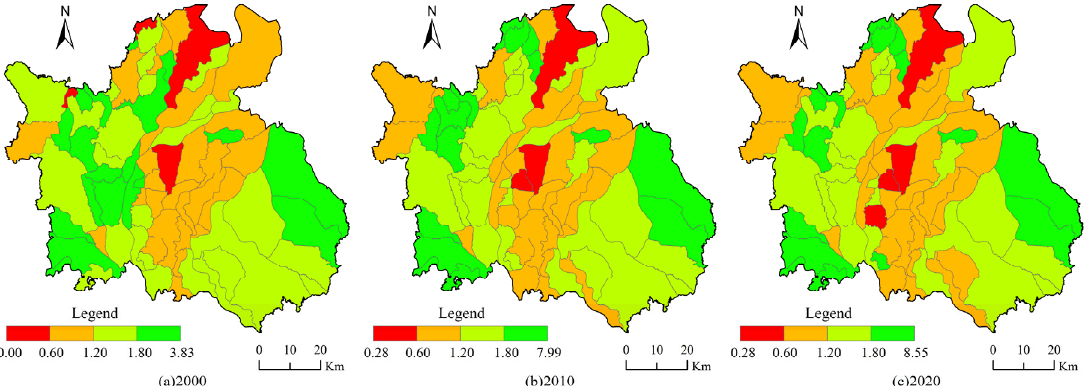
Figure 5. Spatial evolution of morphology resilience of Nanchang City based on water network group.